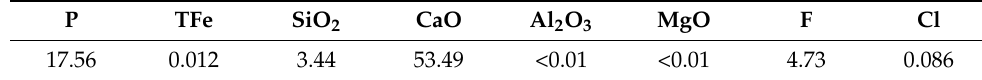
Table 3. Chemical composition of apatite ore (mass